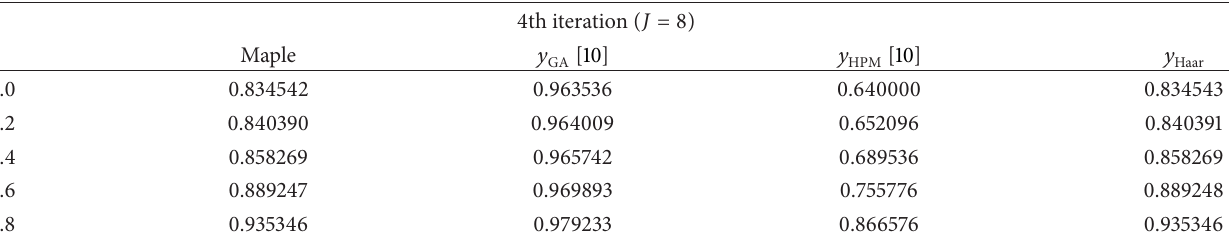
Table 1: Numerical results for temperature distribution equation for 𝜀 = 0.6 : Haar wavelet-quasilinearization technique at 4th iteration and level of resolutions 𝐽 = 8 .